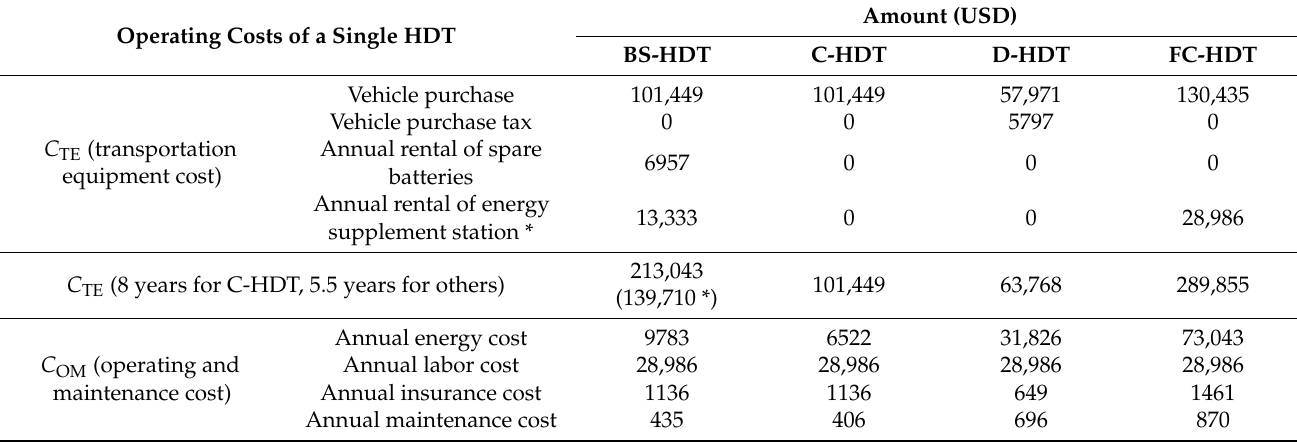
Table 3. Calculation results of operating costs of a single HDT under the four energy supplement modes. Operating Costs of a Single HDT